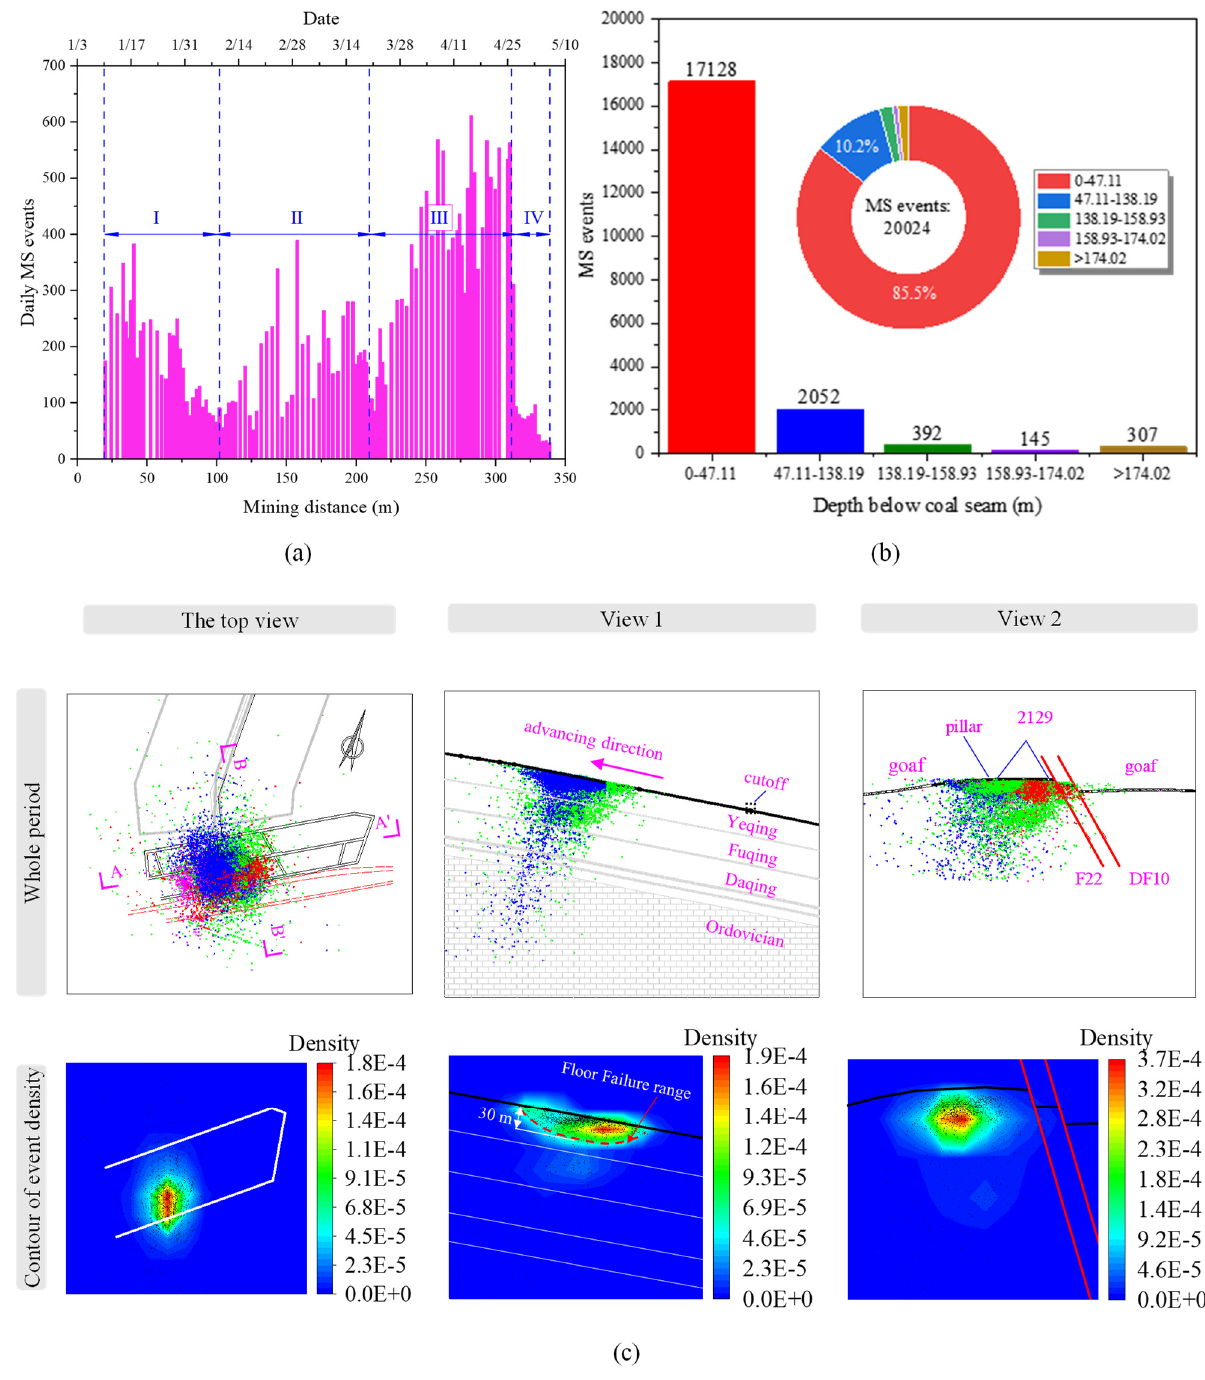
Figure 12. Distribution of MS events in the floor: ( a ) distribution of MS events along strike; ( b ) distribution of MS events in the floor along the floor depth; ( c ) distribution of MS events during monitoring.